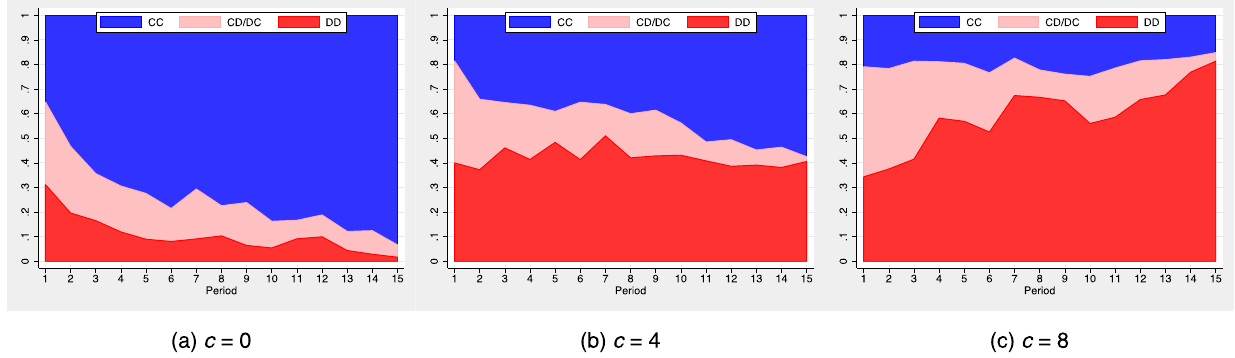
Figure 6. Evolution of link type by cost of obtaining information. Links between two cooperators are shaded blue, links between two defectors are shaded solid red, and mixed links are shaded light red. Links between two cooperators displace other link types almost completely in the free information treatment (a). Links among two defectors displace the other link types almost completely in the high-cost treatment (c). The low- cost treatment has either cooperator or defector links, depending on the final state of the network (b).